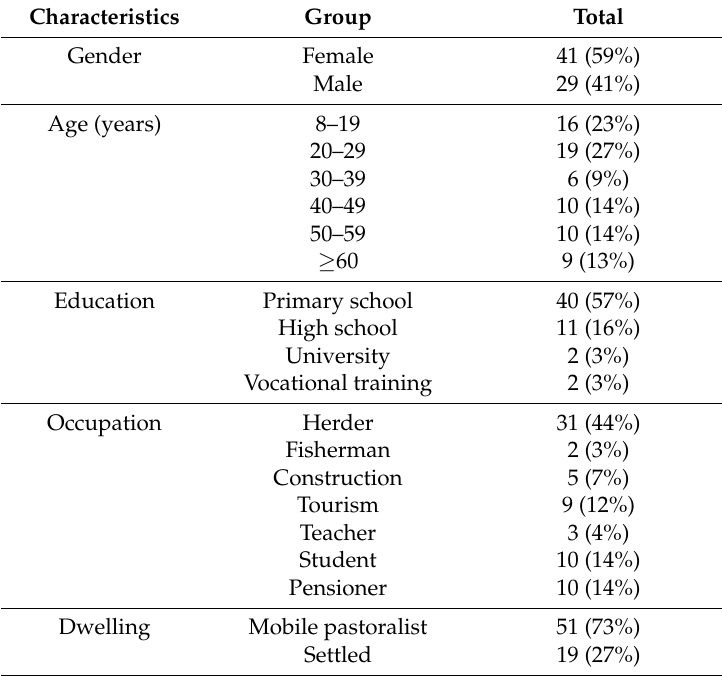
Figure 1. ( a ) Landsat-8 image (Path 135, Row 026; Date acquired 21 July 2017) of study area (2B) and administrative center of KLNP (4B); ( b ) Map showing environs of KLNP. Table 1. Demographic data of participants at